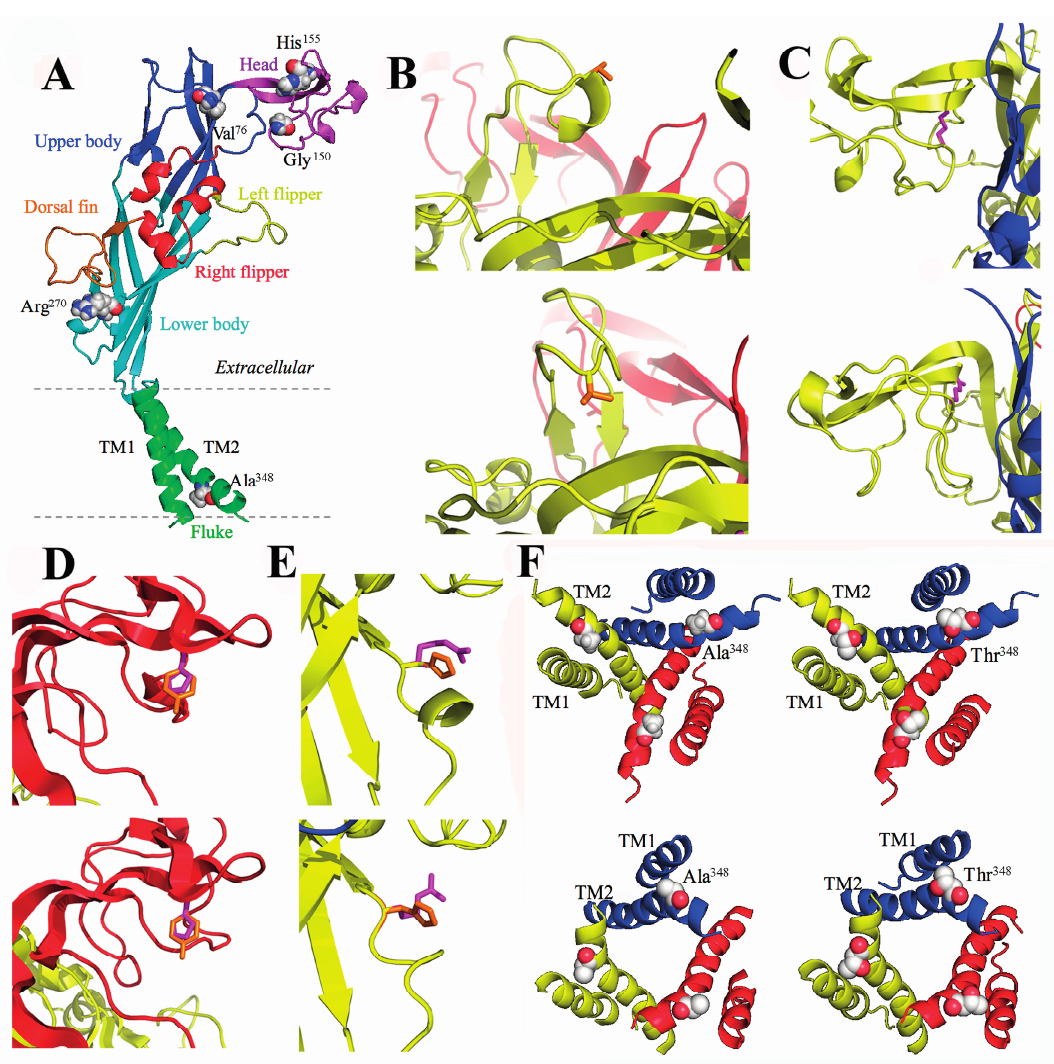
Figure 4. Structural homology models of the human P2X7 receptor. ( A ) the dolphin-shaped structure of a single receptor subunit in the closed state is shown with distinctive body parts in different colours (the same colour scheme used in Figure 2A and Figure 3A for the human P2X2 and P2X4 receptor subunits) and location of the residues to be mutated by disease-associated NS-SNPs are highlighted; ( B – F ) structural differences introduced by the V76A ( B ), G150R ( C ), H155Y ( D ), R270H ( E ), and A348T mutation ( F ) in the closed ( top ) and open state ( bottom ). The original residues are shown in orange and the substituted residues in magenta in ( B – E ). ( F ) is viewed from the cytoplasmic side of the